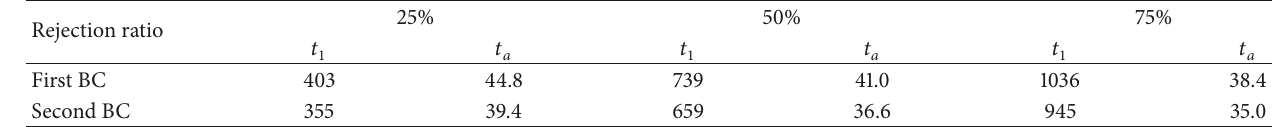
Table 3: Execution time in seconds using ESO.